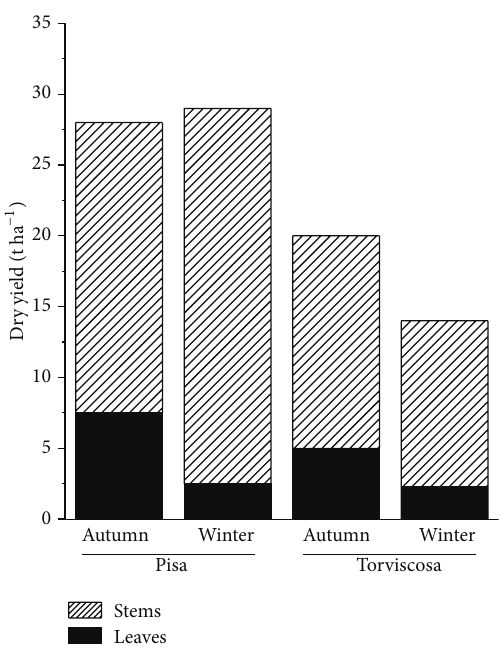
Figure 6: Dry yield of giant reed ecotypes, Pisa and Torviscosa, at autumn and winter harvest